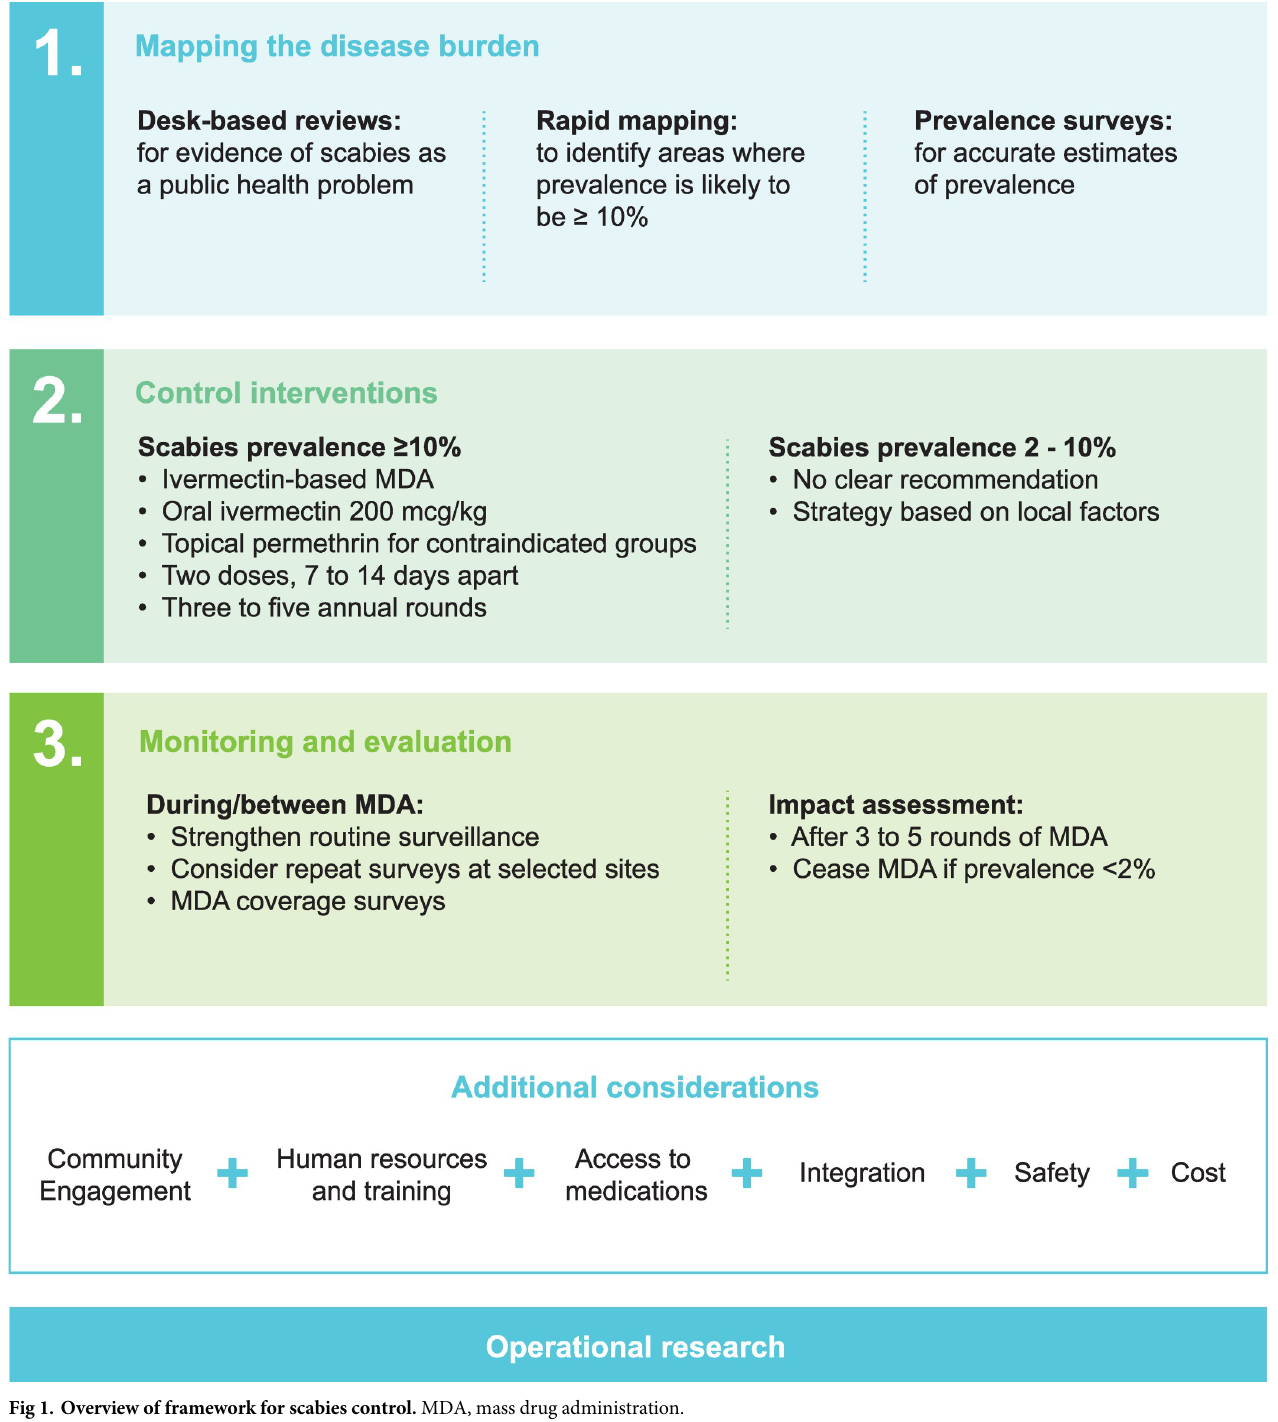
Fig 1. Overview of framework for scabies control. MDA, mass drug administration.